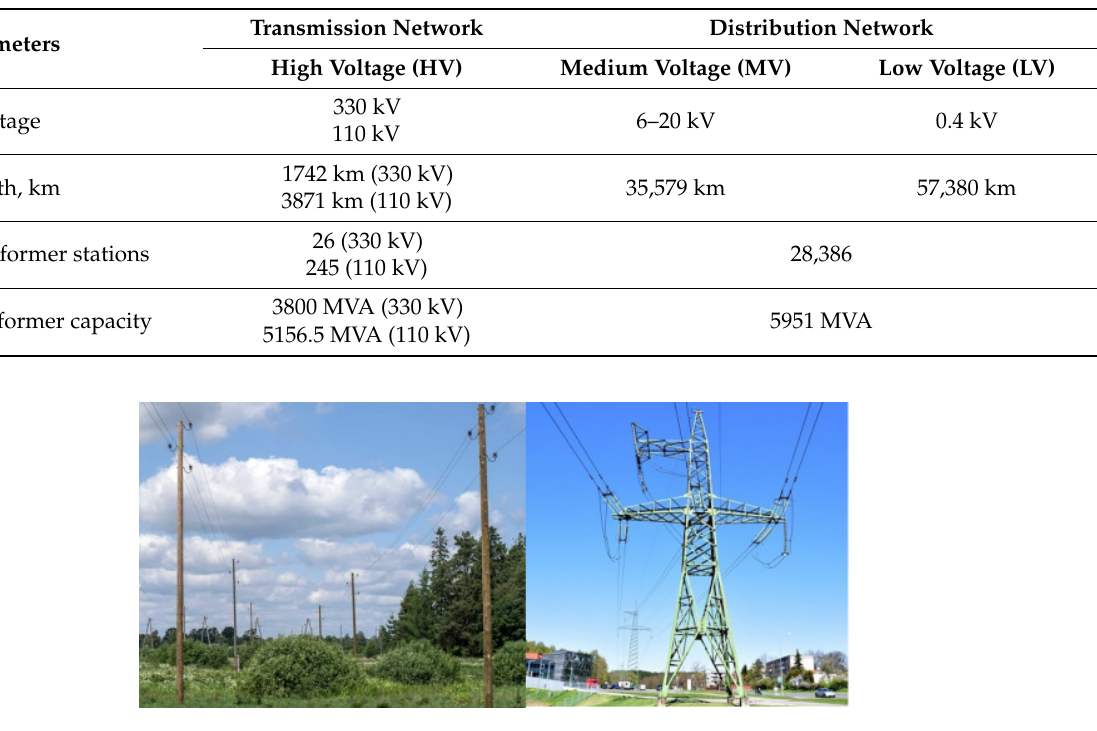
Figure 4. Distribution infrastructure ( left ) and transmission infrastructure ( right